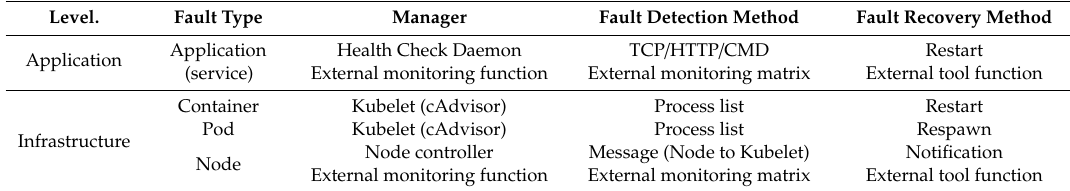
Table 1. Fault management methods in Kubernetes.